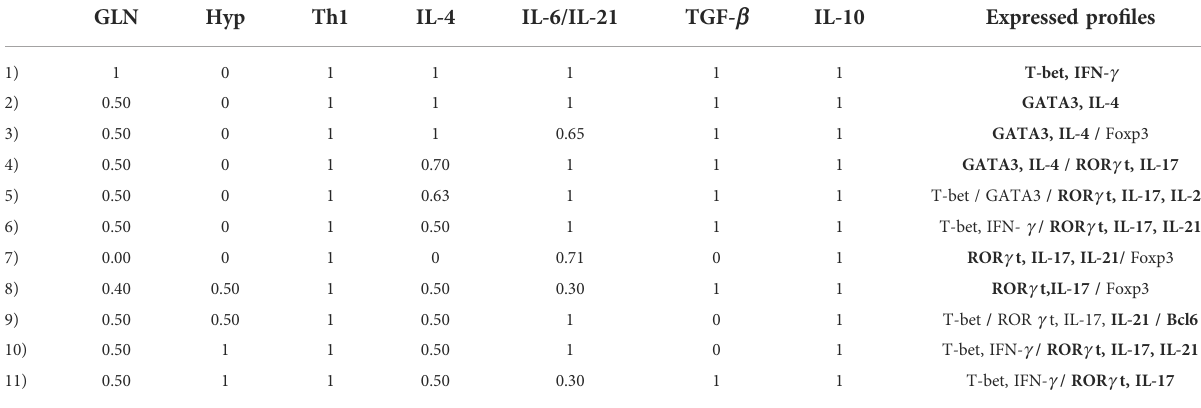
TABLE 1 Phenotype pro fi les induced by de fi cient glutamine levels and/or hypoxic conditions (and optimal tryptophan levels) as function of the relative concentrations of phenotype-inducing cytokines.